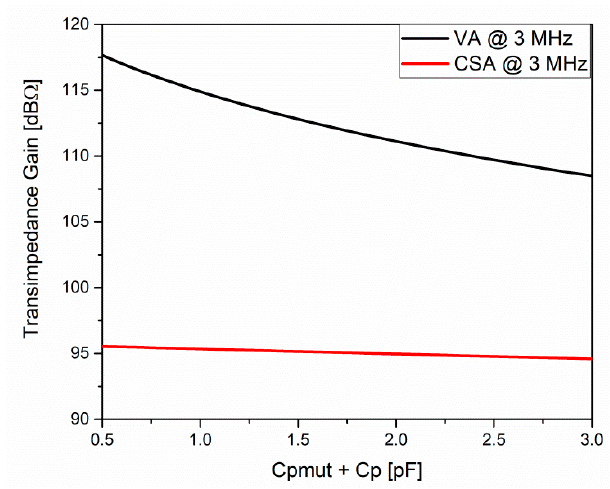
Figure 9. Dependence of the transimpedance gain at 3 MHz, with equivalent capacitance given by the PMUT plus parasitic capacitances.